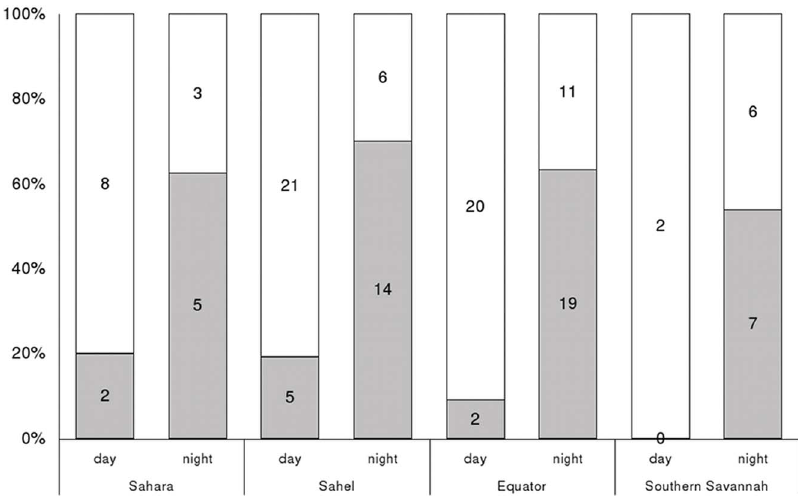
Fig. 2. Travelling activity during migration of Rollers. Percentage of segments flying faster than 5 km/h in relation to time of day and overflown region. Numbers on bars indicate the number of segments in each category (grey for travelling segments, white for stationary